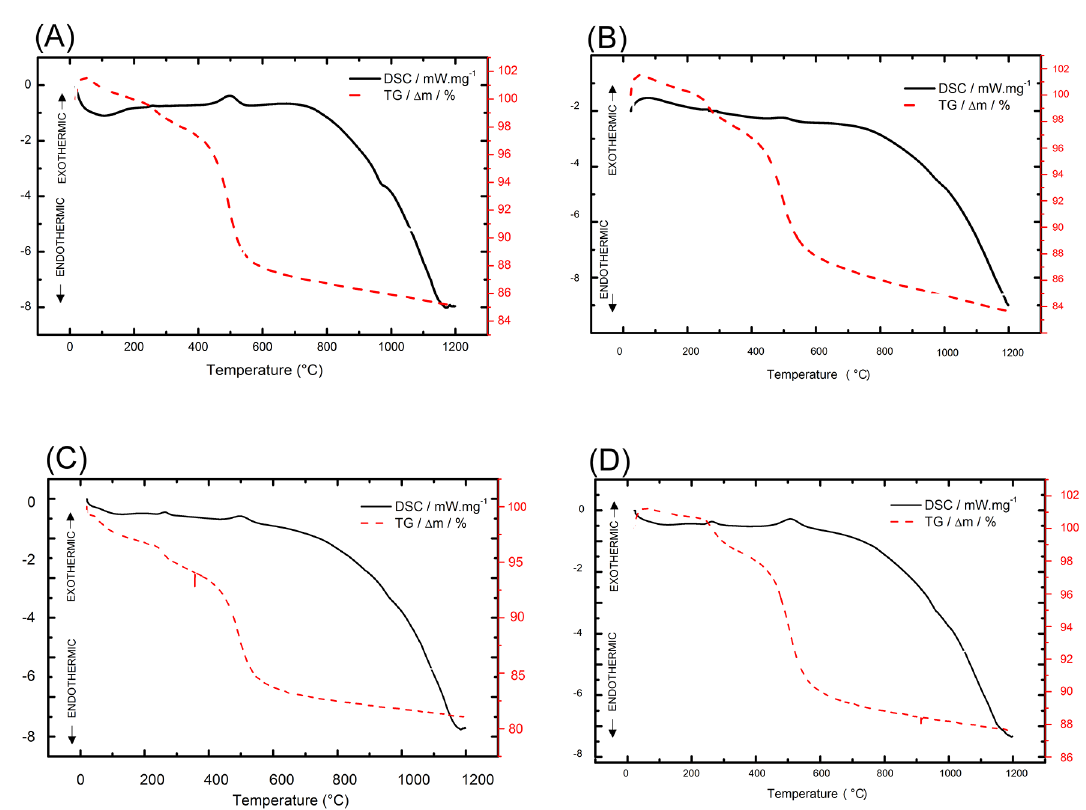
Figure 3. Curves DSC/TG of clays A, B, C, D